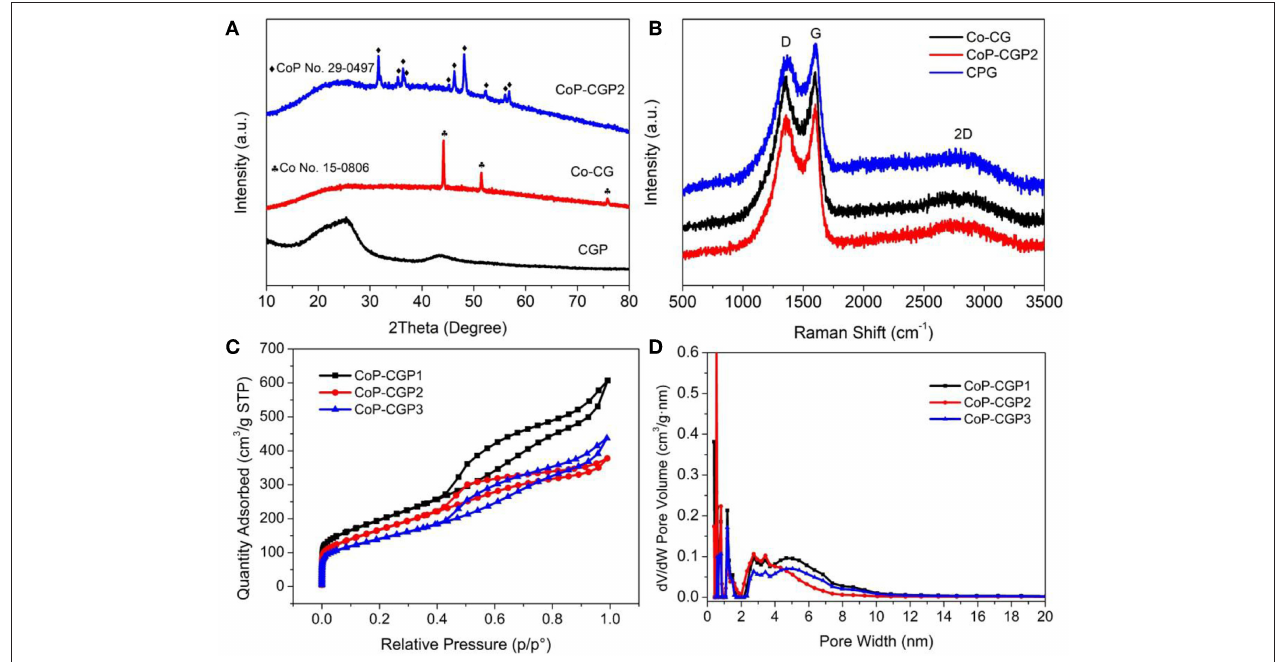
FIGURE 3 | (A) X-ray diffraction (XRD) patterns; (B) Raman spectra; (C) N 2 adsorption/desorption isotherms; and (D) pore size dispersion plots.